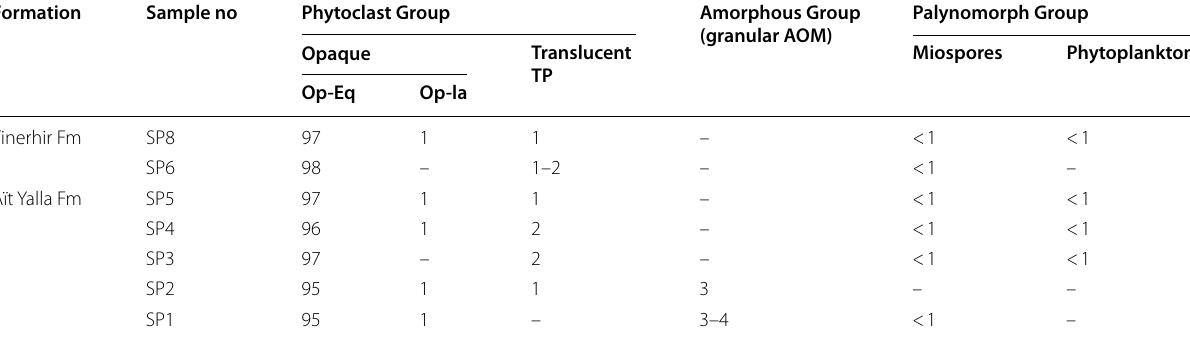
Op-Eq: opaque equidimensional; Op-la: opaque lath-shaped; TP: translucent phytoclast; AOM: amorphous organic matter